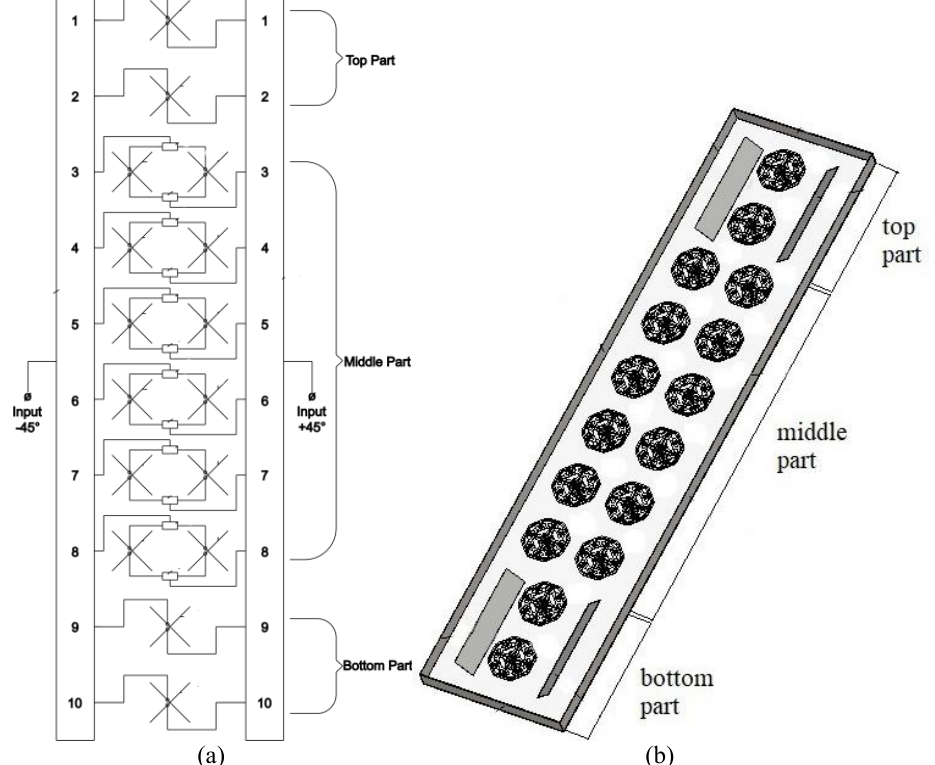
Fig. 2 . The proposed antenna array (a) simplified electric circuit, (b) perspective top